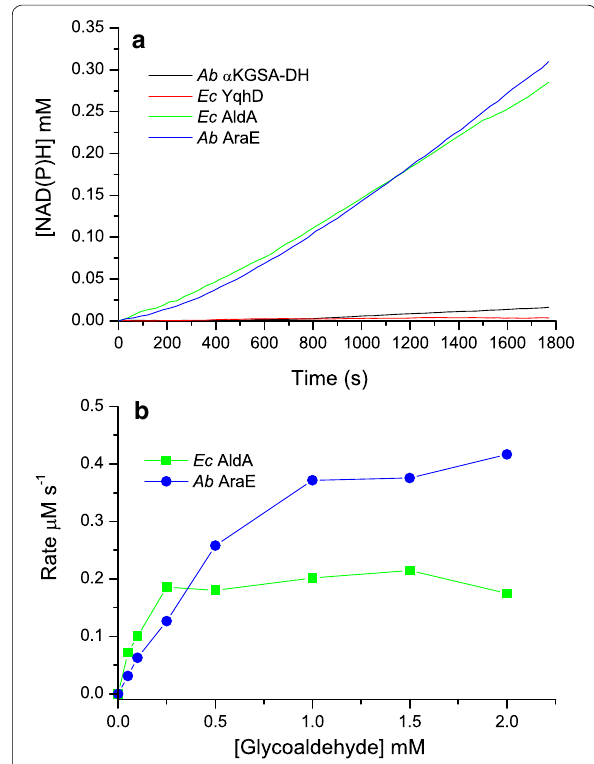
Fig. 7 a Evaluating four alternative enzymes for the production of glycolic acid from glycolaldehyde. The production of glycolate was always followed through generation of NAD(P)H from the enzymatic oxidation step from glycolaldehyde to glycolic acid using 110 µg Ab αKGSA-DH (black line), 1.5 µg Ab AraE (blue line), 2 µg Ec AldA (green line) and 140 µg Ec YqhD (red line). The reaction mixture contained 50 mM Tris HCl pH 7.0, 10 mM MgCl 2 , 2 mM NAD or NAD(P), 1 mM DTT, 1 mM xylonolactone, 4 ug Cc XylC, 6 µg Cc XylD and 2 µg Ec YagE. b Glycolaldehyde concentration dependent steady-state kinetics comparison when using Ec AldA (circles) and Ab AraE (squares). The reaction contained 50 mM Tris HCl pH 7.0, 2 mM NAD, 1 mM DTT, glycolaldehyde 0–2 mM, 2 µg Ec AldA or 1.5 µg Ab